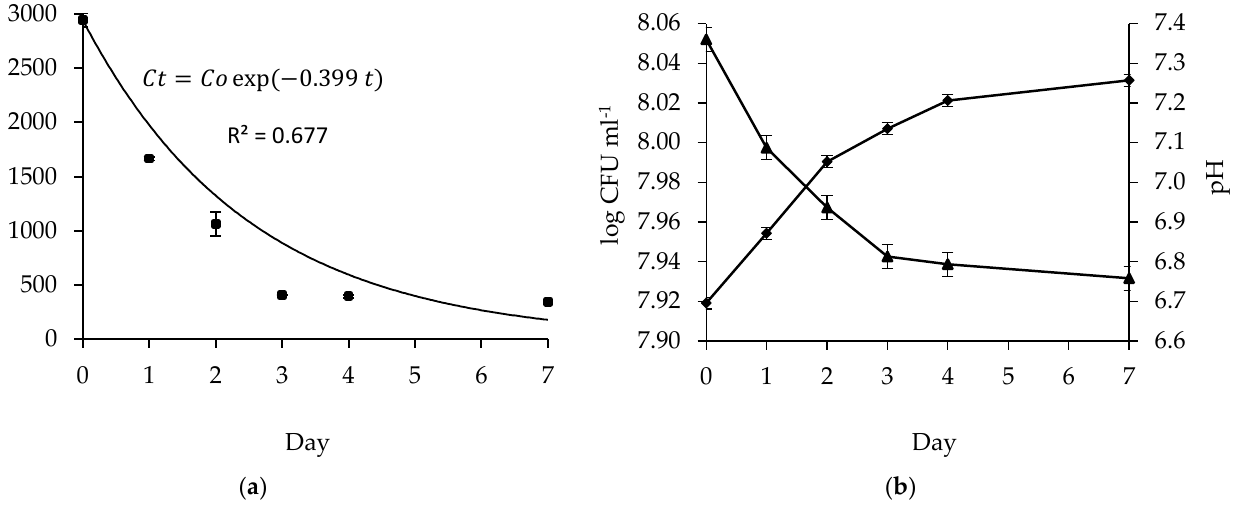
Figure 7. ( a ) The biodegradation rate of oil ( ), ( b ) bacteria population ( ), and pH ( ) during experiment.